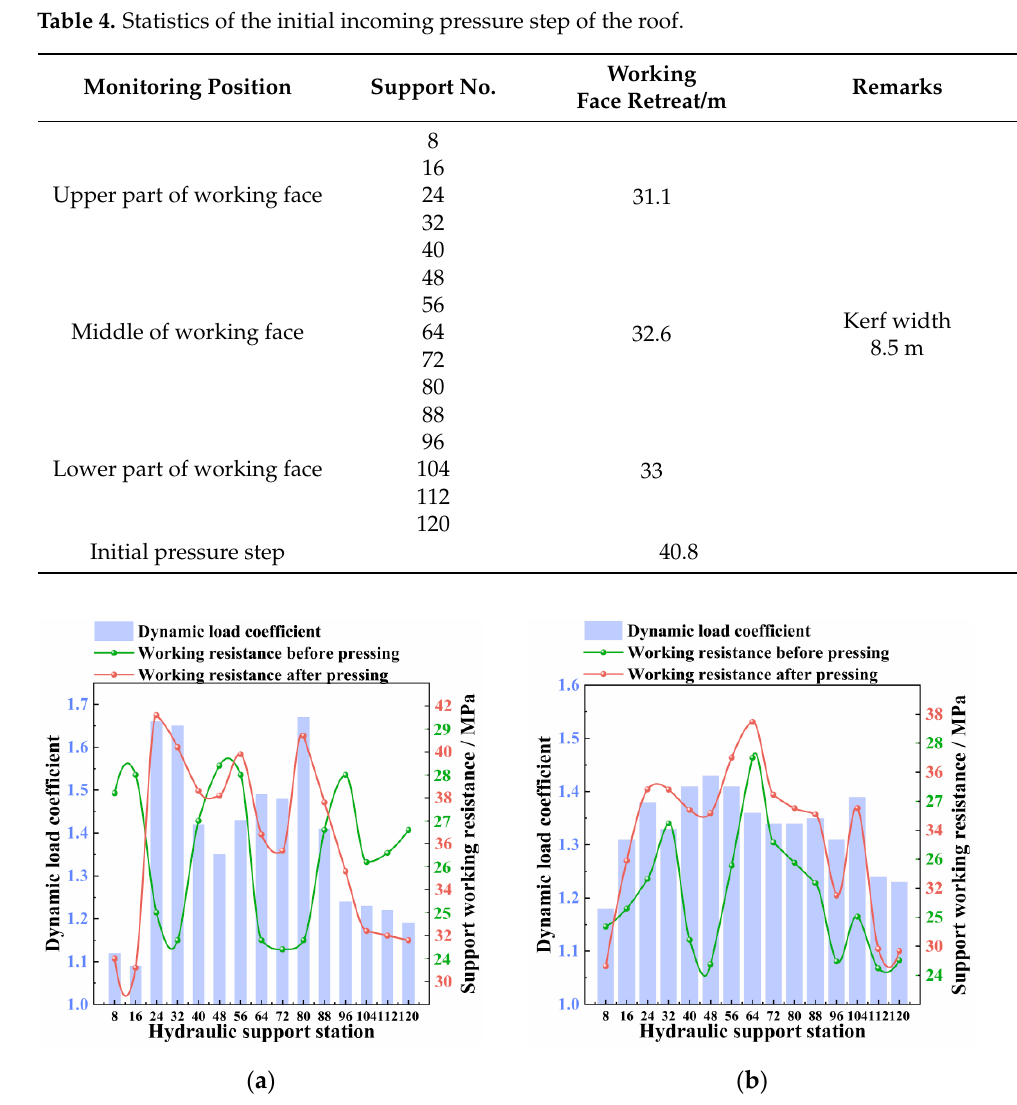
Figure 15. Change of support resistance and dynamic load coefficient: ( a ) is the change curve of dynamic load coefficient of each station stand when the initial pressure comes after the roof is cut; and ( b ) is the change curve of dynamic load coefficient of each station stand when the pressure comes periodically after the roof is cut.